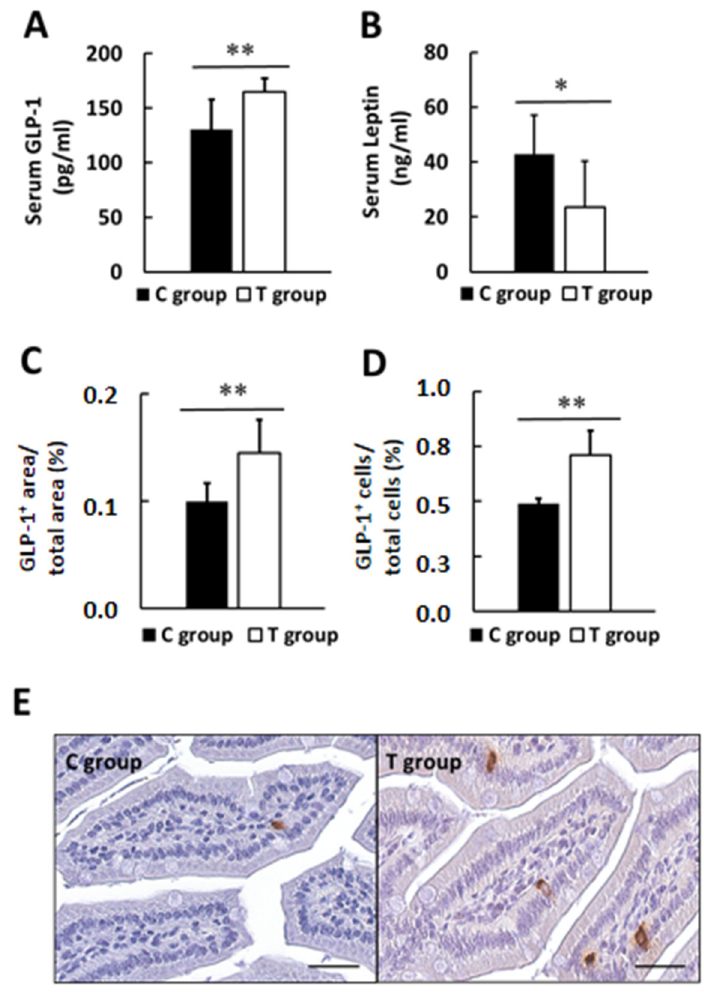
Figure 5. ( A ) Effect of probiotic supplementation on serum GLP-1 levels and ( B ) leptin levels. ( C ) GLP-1 positive area (%) and ( D ) GLP-1 positive cells (%) in intestinal histological samples. ( E ) Representative immunostaining for GLP-1 in small intestine. Values are expressed as mean ± SD. * p < 0.05, ** p < 0.01. Scale bars: 25 µm.